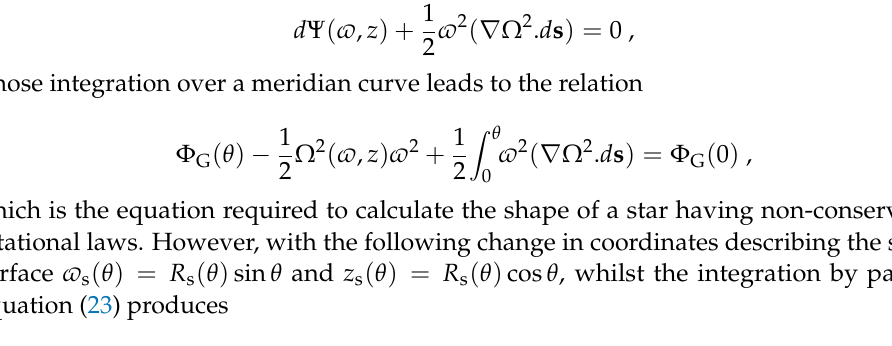
Figure 17. Differential rotators. ( a ): Iso-density surfaces in model stars of M = 15 M (cid:12) in the ZAMS having the internal rotation law (20) whose parameters Ω o / Ω cr and β are indicated: ( a1 ) β = 4.0, Ω Ω Ω Ω Ω Ω Ω o / cr = 4.0; ( a2 ) β = 6.0, o / cr = 7.0; ( a3 ) β = 8.0, o / cr = 9.6. cr is for the critical rigid rotation. The iso-density surfaces are labeled with the corresponding density ratios ρ / ρ c , which are the same as in Figure 16 and for all panels of this figure. ( b ): Iso-density surfaces in the model stars of M = 15 M (cid:12) in the TAMS having the internal rotation law (20), whose parameters Ω o / Ω cr and β are indicated: ( b1 ) β = 4.0, Ω o / Ω cr = 4.0; ( b2 ) β = 6.0, Ω o / Ω cr = 7.0; ( b3 ) β = 8.0, Ω o / Ω cr = 8.5. Ω cr is for the critical rigid rotation. In each panel, the ordinates are in the same scale as the abscissas, but they differ from one to the other panel. Adapted from Zorec et al.